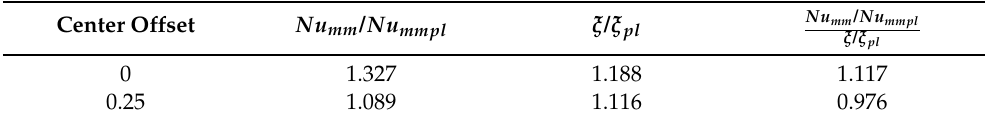
Table 5. Comparison of the heat transfer, hydraulic losses, and thermal-hydraulic efficiency of a channel section with two dimples 0.2